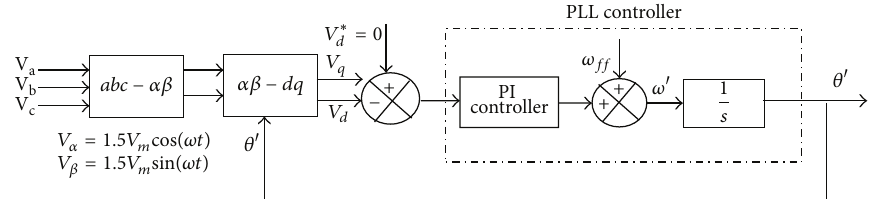
Figure 5: Block diagram of phase locked loop based on synchronous reference frame.